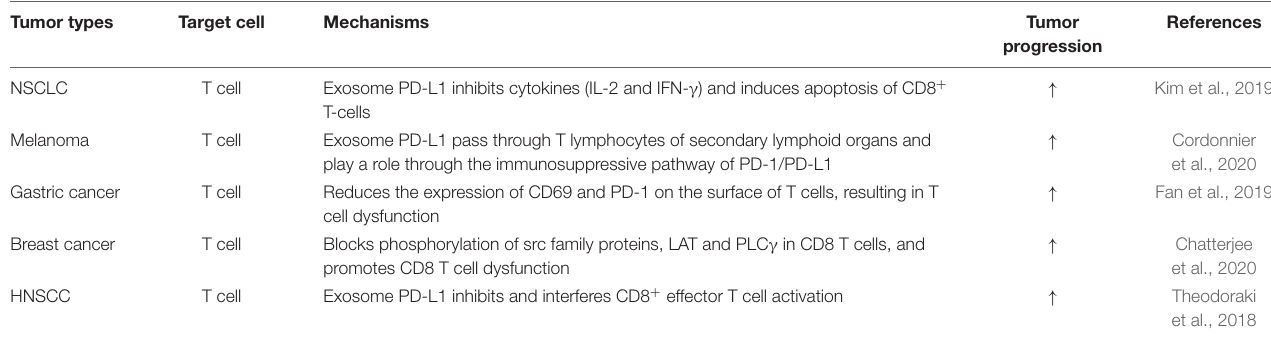
TABLE 1 | Tumor-derived exosome PD-L1 in